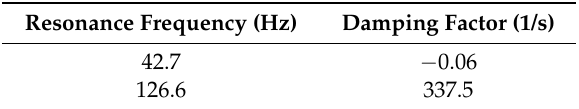
Table 5. ENRS analysis of the wind farm integration system with an MMC.